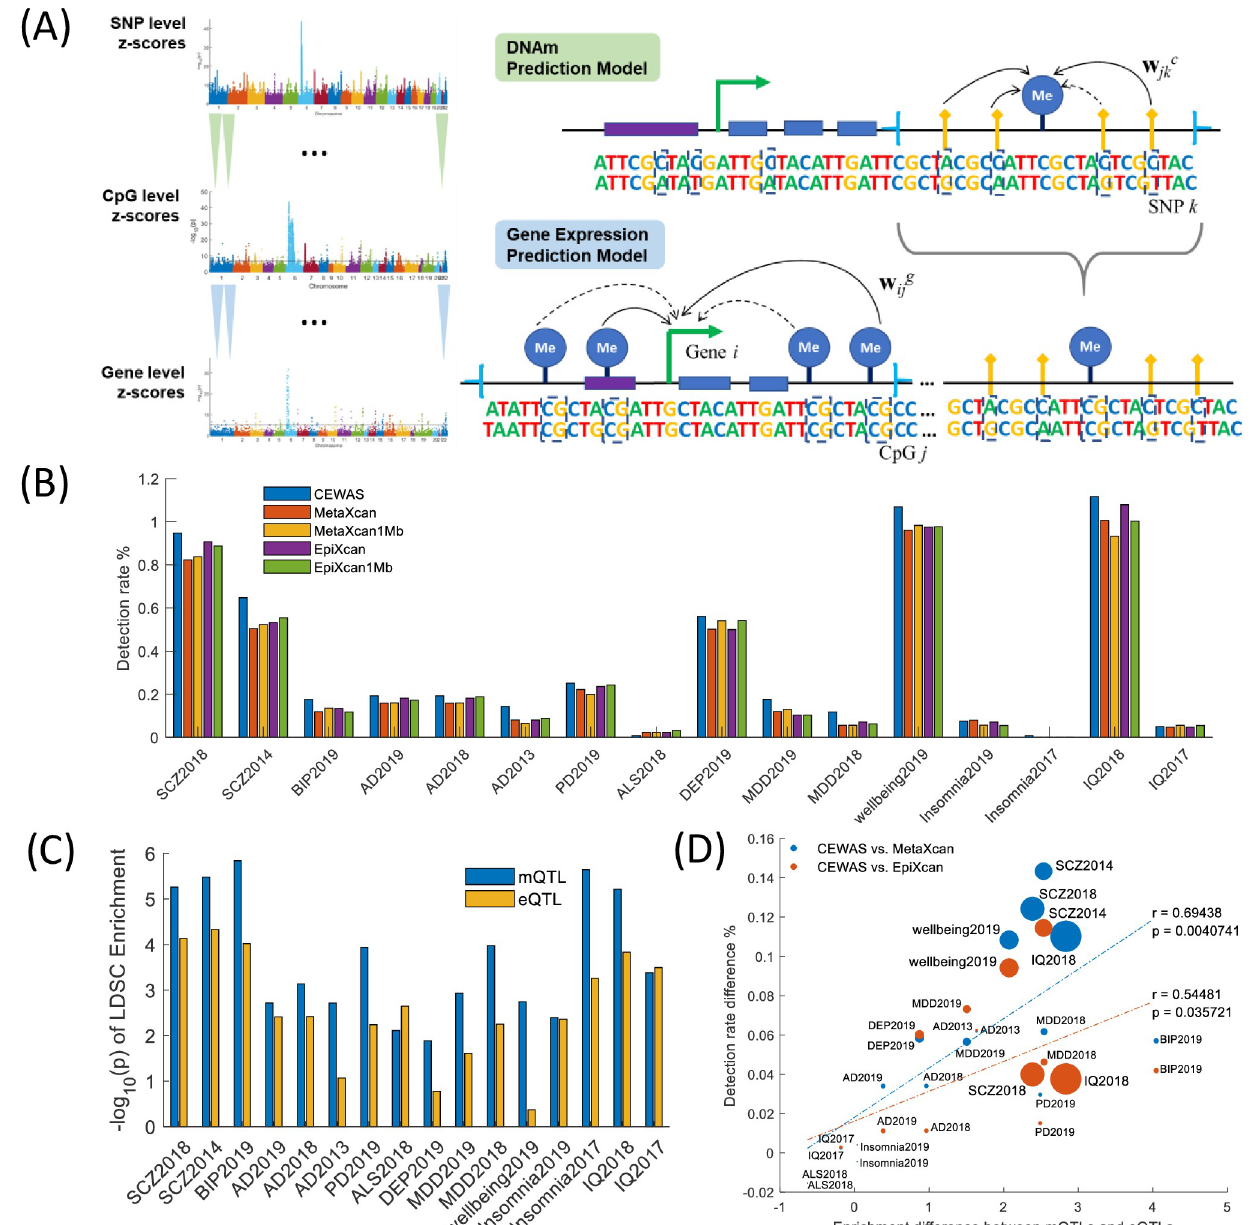
Fig 1. CEWAS and gene detection. (A) For each CpG j , a DNAm prediction model is built using dosage levels of proximal SNPs, and for each gene i , a gene expression prediction model is built using predicted DNAm levels of proximal CpGs. Elastic net is used for model learning, where solid and dotted lines pictorially indicate non-zero and zero weights for the corresponding variable pairs. These models are applied in cascade to GWAS summary statistics to estimate gene level z-scores. (B) Bars show the detection rate (defined as the percentage of tested genes declared significant) for the examined GWAS. (C) Bars show the log p-value of enrichment of mQTLs and eQTLs assessed by LDSC for each GWAS. The baseline SNP sets in LDSC corresponding to various regulatory attributes are included as background. (D) Difference in mQTL vs. eQTL log p enrichment (from Fig 1C) plotted against difference in detection rate between CEWAS and a contrasted method (color of the points indicate which method is being contrasted with CEWAS). The size of a point is proportional to the polygenecity of the corresponding GWAS (approximated by the ratio of the number of reported GWAS loci over the sample size). As shown, enrichment for mQTLs over eQTLs significantly correlates with improvement in detection achieved by CEWAS over contrasted methods (p < 0.05).